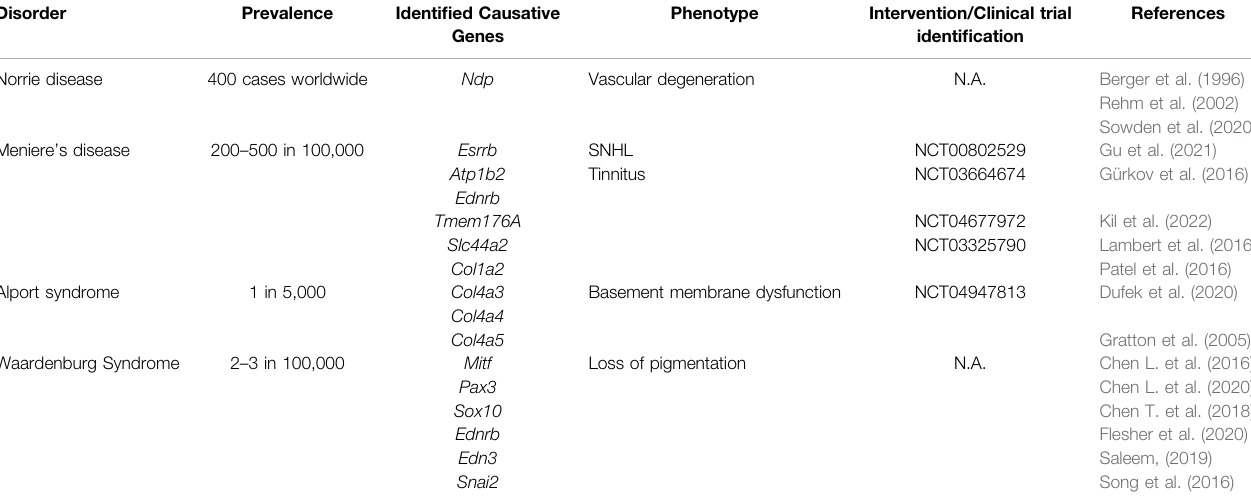
TABLE 1 | Summary of SV disorders and associated clinical